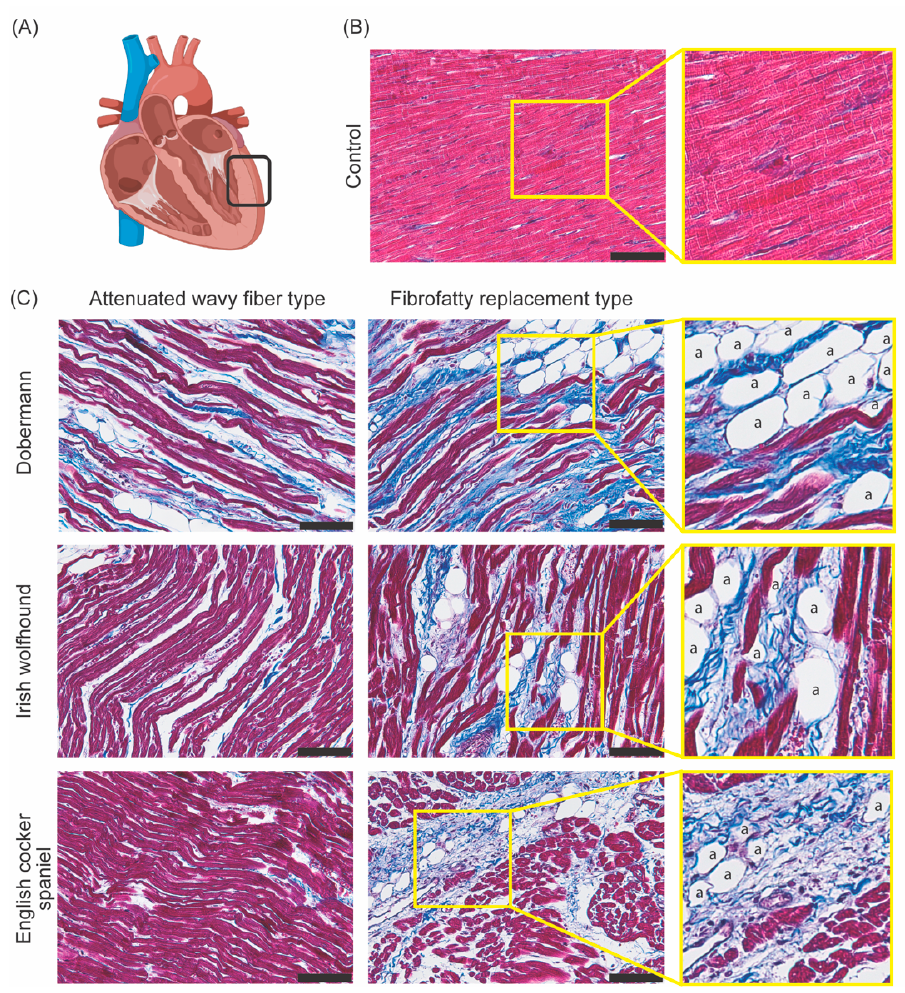
Figure 1. Histologically distinct forms of canine DCM. Masson’s trichrome staining of 4 µ m thick paraffin embedded slides [39]. (Red = cardiomyocytes, blue = fibrotic/connective tissue, a =